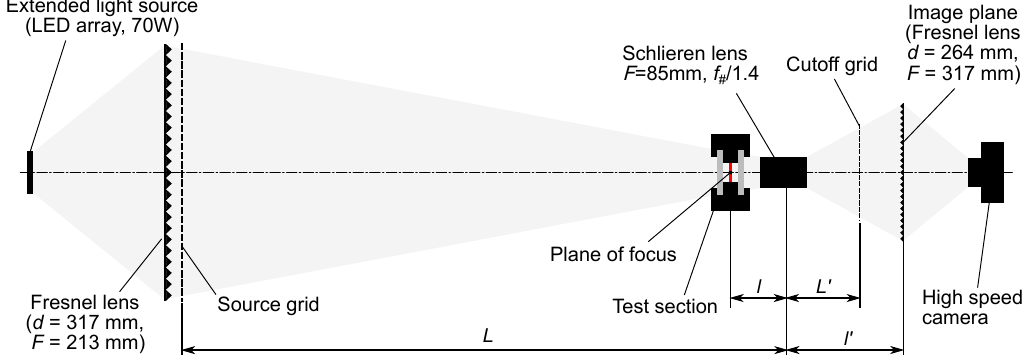
Figure 2. Schematic layout of the focusing schlieren system with technical data of the main